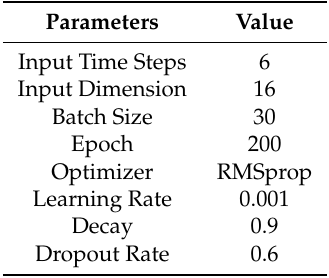
Table 6. Parameter setting in the proposed